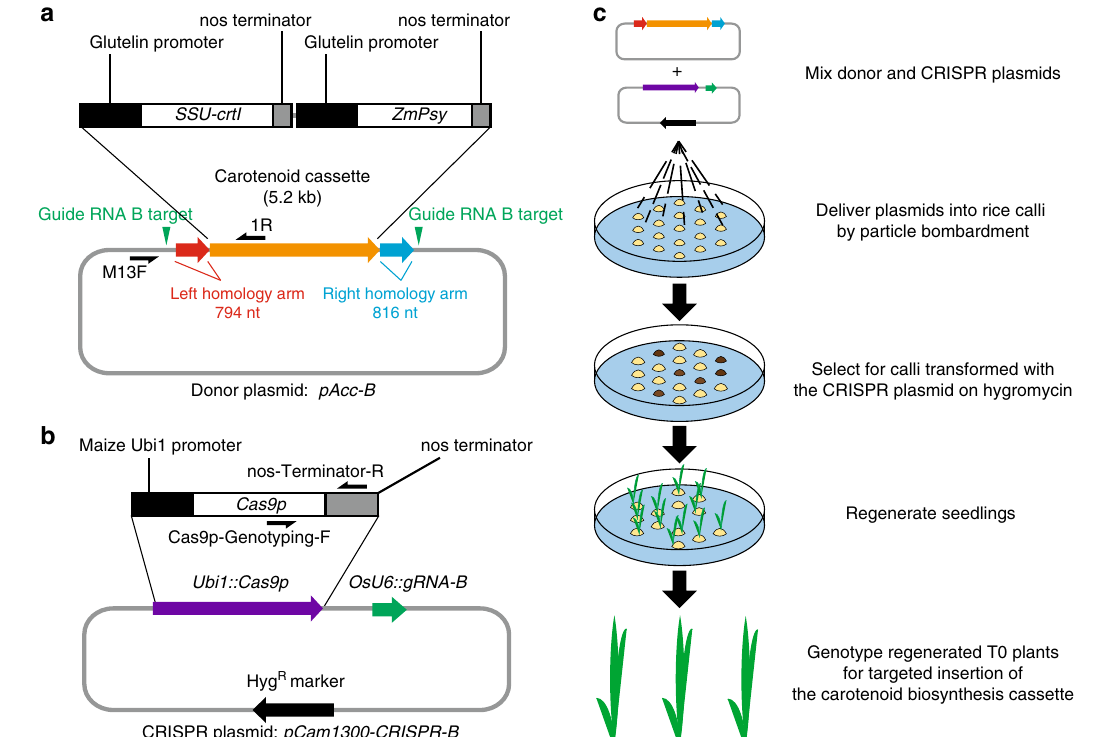
Fig. 1 Scheme for targeted insertion of the carotenoid cassette. a Map of the donor plasmid pAcc-B with details of the carotenoid cassette (orange arrow). Red and blue arrows represent the homology arms. The two vertical green triangles mark the positions of the guide RNA B target sites. The nucleotide sequence of the donor plasmid is presented in Supplementary Data 1. Primers used to genotype the donor plasmid are marked on the map. b Map of the CRISPR plasmid pCam1300-CRISPR-B . Genes encoding Cas9p , gRNA-B , and hygromycin resistance (Hyg R ) are represented by purple, green, and black arrows, respectively. The Cas9p module is shown in detail. Primers used to genotype Cas9p are marked on the map. c , Scheme for transformation, selection, and